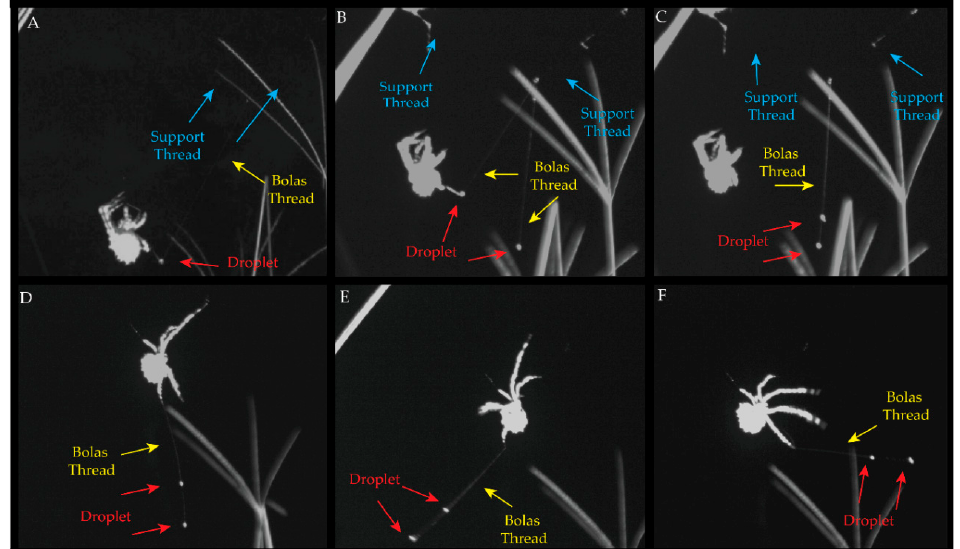
Figure 3. Breakdown of Multi-Bolas Creation and Prey Capture Behavior. The spider shown has a carapace width of 12 mm. Red arrows in each image are glue droplets and yellow arrows show the bolas capture thread. C. akermani sits on its grass or leaf until sundown. Like other spiders it first moves up and along the top of its leaf or grass stalk, creating a simple beam. It then waves its long legs in the air, wafting them about. ( A ) the spider creates two support threads (blue arrows), sliding down one and attaching a bolas to one strand. It lets the droplet slowly fall away as it gets larger. ( B , C ) then moves back up to the top anchoring another thread to the support beam. It drops back down again, but not as far as previous, and creates another glue droplet, which is allowed to swing into the other strand, making a single overall structure. ( D ) Once finished, the spider orients itself parallel to the support bar, grabs the bolas with its lower second leg, and holds its especially long and hairy front legs out. ( E ) It spins the bolas in a circle with its anchoring second leg. ( F ) after it has a consistent and circular motion started with the droplets, the spider begins to swing its front legs back and forth,